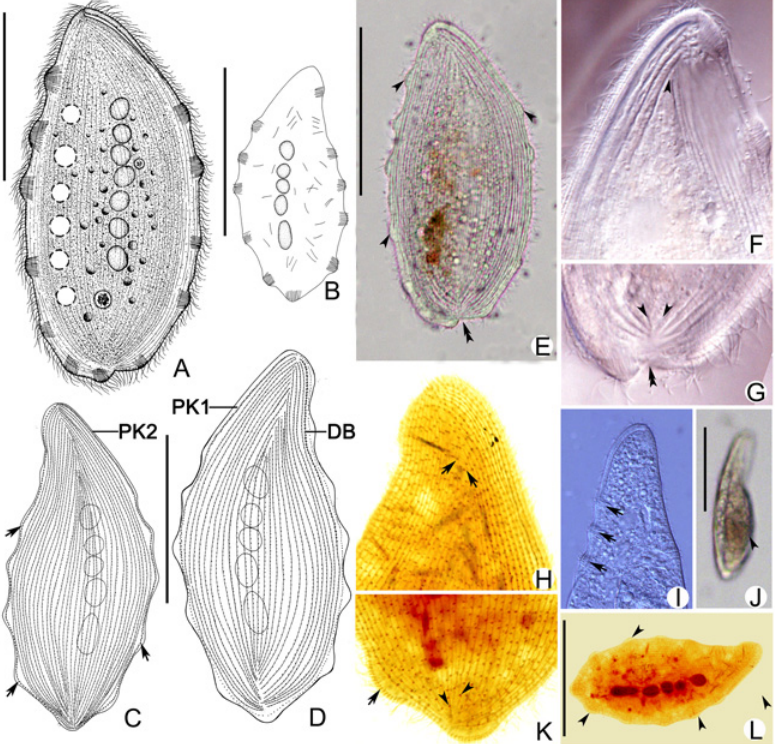
Fig 3. Kentrophyllum strumosum sp. n.; living individual (A-D, E-G, I, J) and cells stained with protargol (H, K, L). A. Right lateral view of representative specimen. B. Left lateral view, showing distribution of extrusomes and warts (arrowheads). C, D. Ciliary patterns of right (C) and left (D) side; arrows, perioral kinety 2. E. Right lateral view, showing erose posterior (double arrowheads) and warts (arrowheads). F, I. Anterior part of left side showing extrusomes in the warts and suture (arrowhead). G. Posterior part of left side showing grooves (arrowheads) and erose posterior (double arrowheads). H. Anterior part of right side indicating suture (arrows). J. Lateral side view, showing the arched left side (arrowhead). K. Posterior part of left side, showing suture (arrowheads). L. Right lateral view, showing perioral kinety 2 (arrowheads). Ma, macronuclear nodules. DB, dorsal brush; PK1, perioral kinety 1; PK2, perioral kinety 2. Scale bars, 100 μ